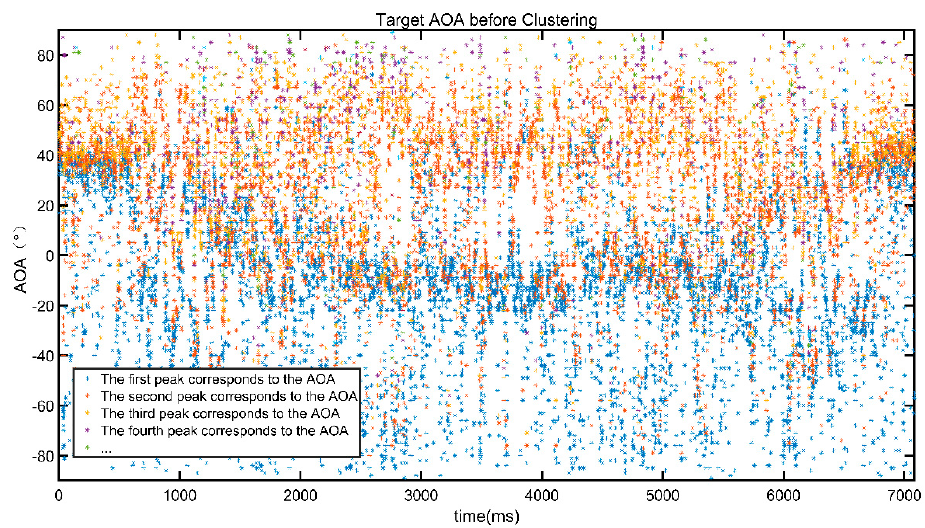
Figure 5. AOA value of the dynamic target after joint